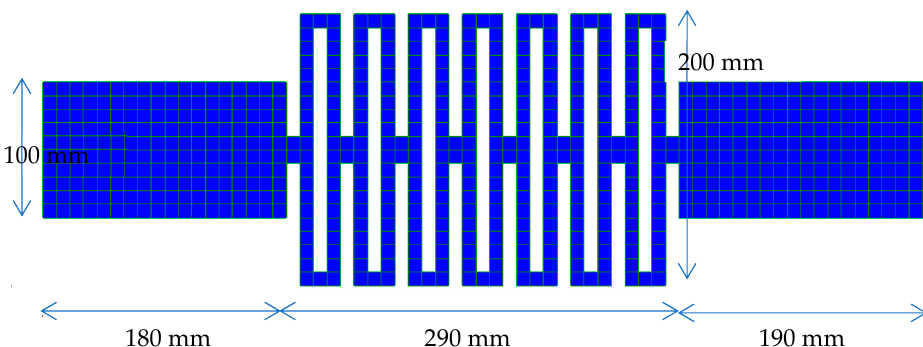
Figure 5. Dimensions of test specimen F-8 (10 mm grids). Gripping